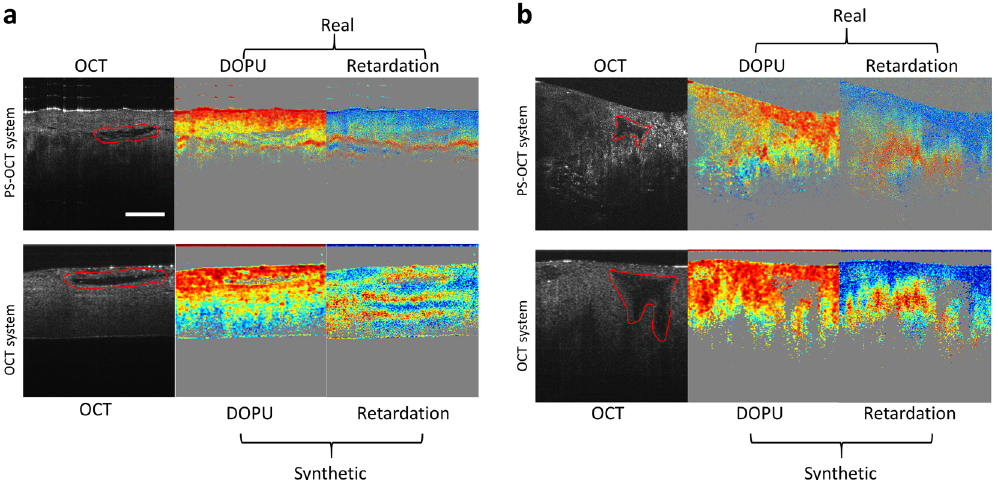
Fig. 5 Application of the prediction models on images collected by a standard OCT-only imaging system with the same wavelengths as the PS-OCT imaging system. By imaging the same tissue sites from ( a ) chicken skin and ( b ) chicken muscle, the synthetic PS-OCT images from the OCT system were directly compared with the real PS-OCT images collected by the PS-OCT system. Similar features are encircled by the red lines. The 200 μ m scale bar applies to all images.